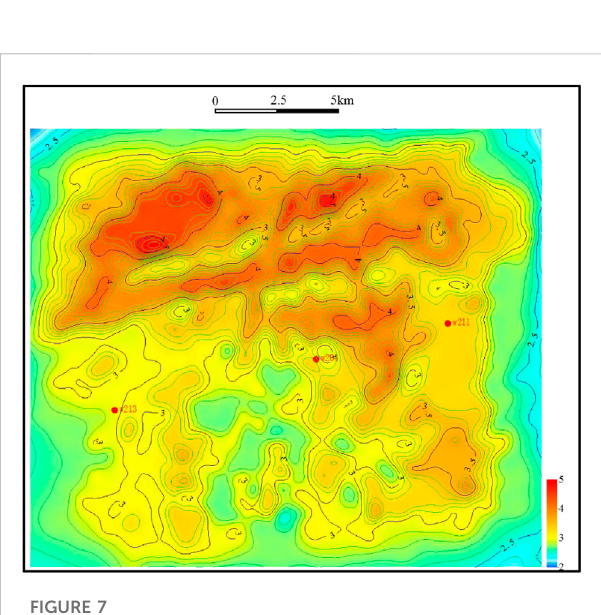
FIGURE 7 Planar distribution map of shale TOC in the W204 well area